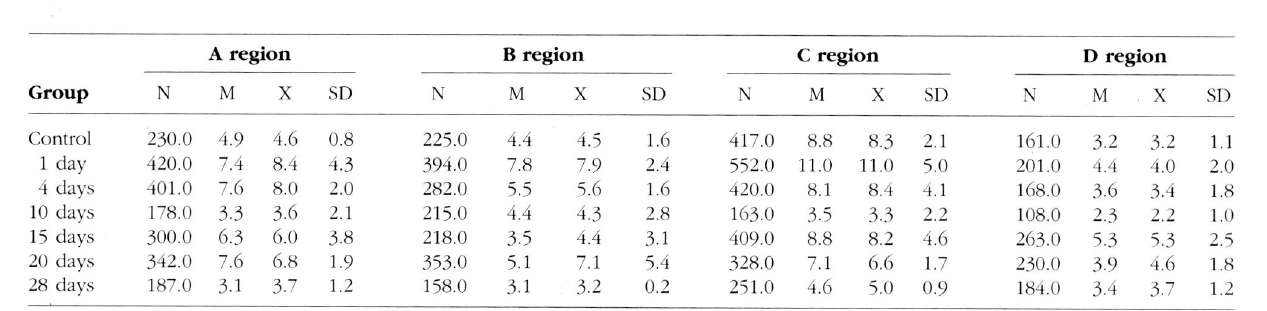
Table II. - Total number (N), median (M), mean (X) and stand deviation (SD) of mast cells counted in the four skin regions of the control and infested rat with Dermatobia hominis larvae.